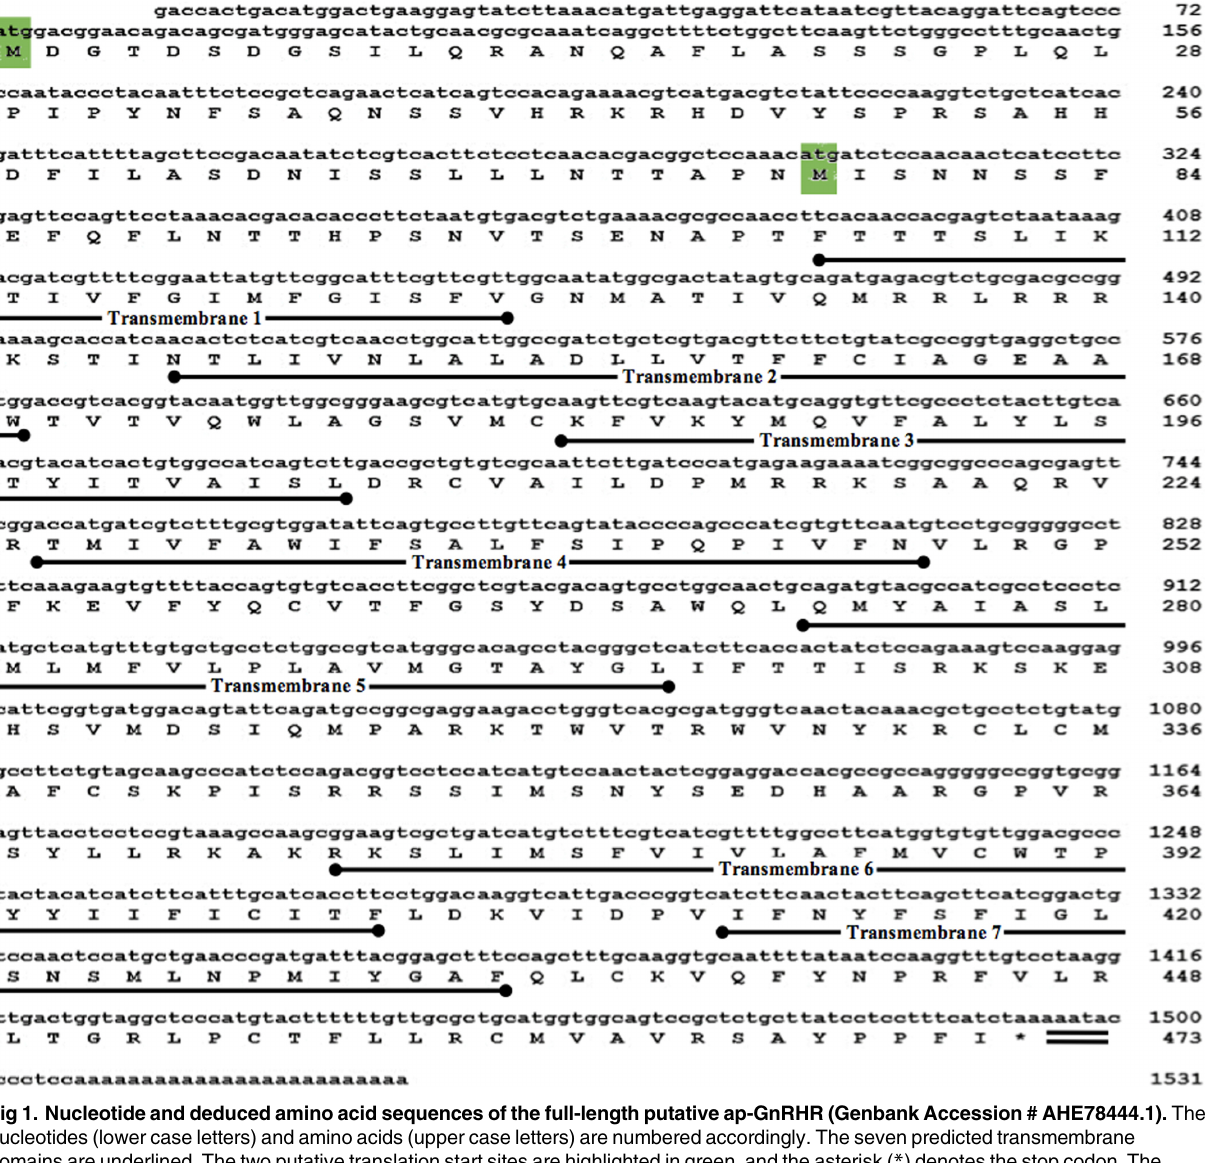
PLOS ONE | DOI:10.1371/journal.pone.0160292 July 28,